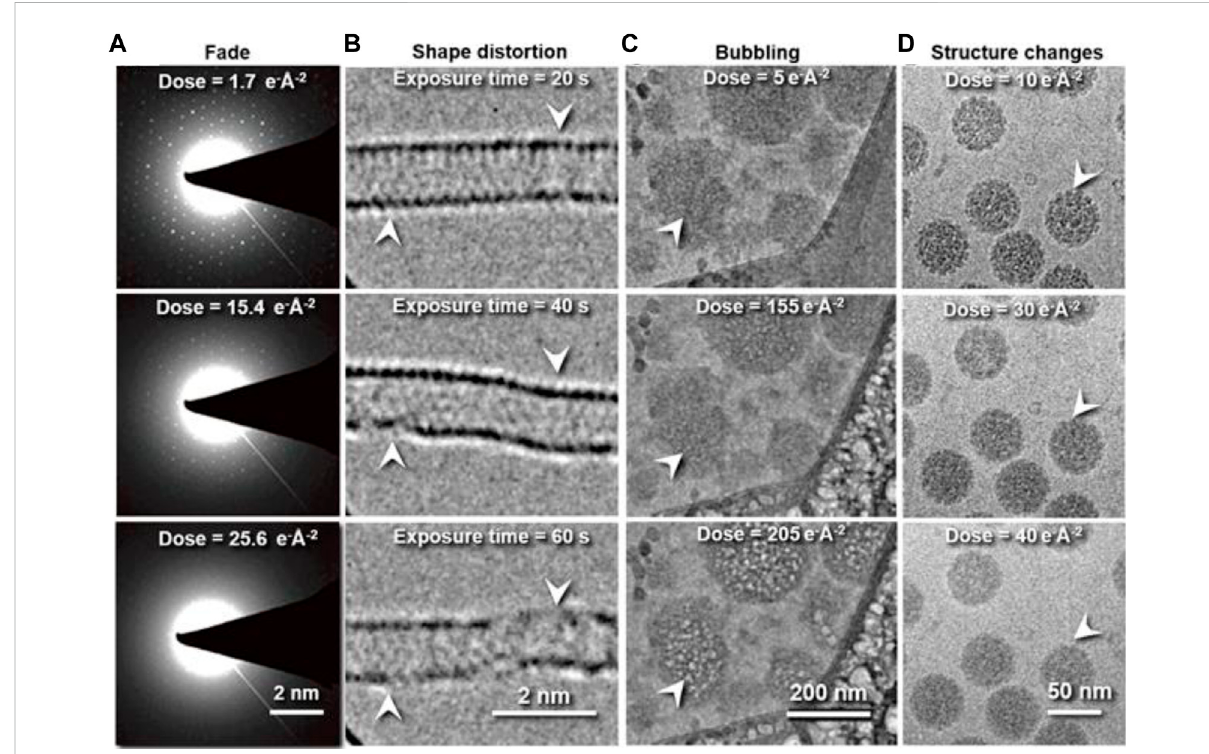
FIGURE 1 Typical phenomena induced by radiation damage under electron beam. (A) Re fl ection fade phenomena: Sequential electron diffraction patterns of purple membrane 2D crystals under a series of electron dose. As the dose increases, the spots fade, indicating cumulative radiation damage to the crystal. Reproduced with permission (Peet et al., 2019). (B) Distortion phenomena: Time series of SWNT images under constant electronbeamirradiation.Reproducedwithpermission(Warneretal.,2009). (C) Bubblingphenomena:Bubblesappearwithincreasedelectron dose. Reproduced with permission (Daffner et al., 2020). (D) Structure-changing phenomena: Radiation damage in vitri fi ed SV40 samples. Fine structural details are progressively lost in the SV40 particles as the electron dose increases from 10 to 40 e − Å − 2 . Reproduced with permission (Baker et al.,